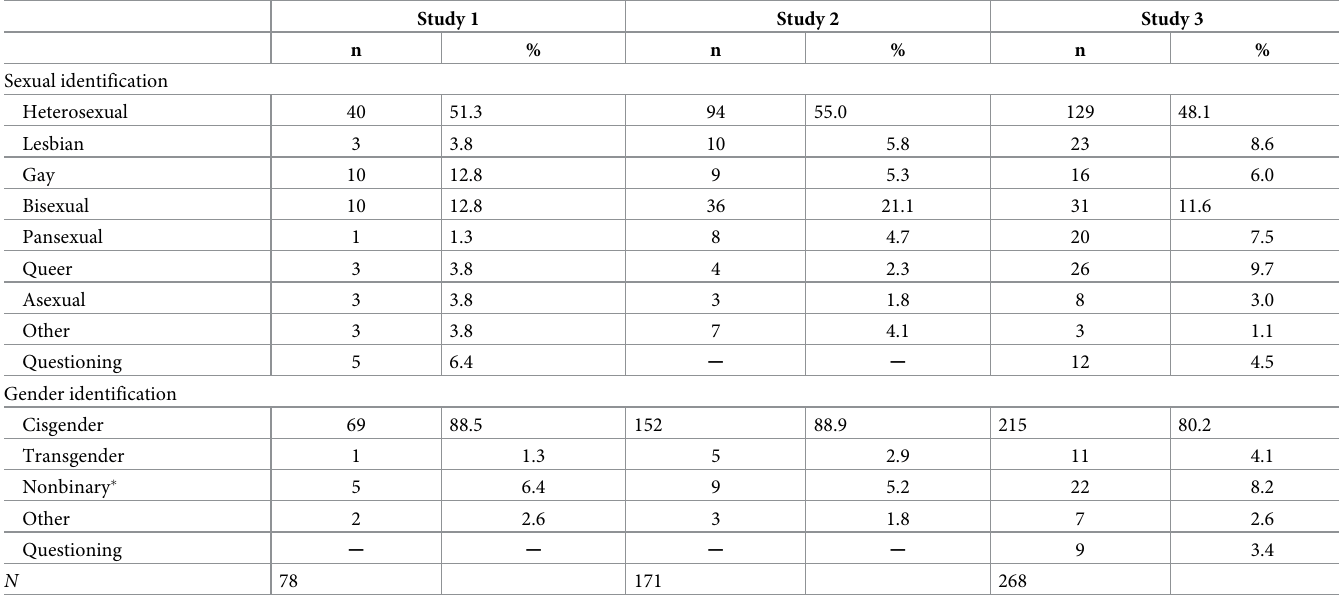
Table 1. Distribution of self-reported sexual and gender identification. Study 1 Study